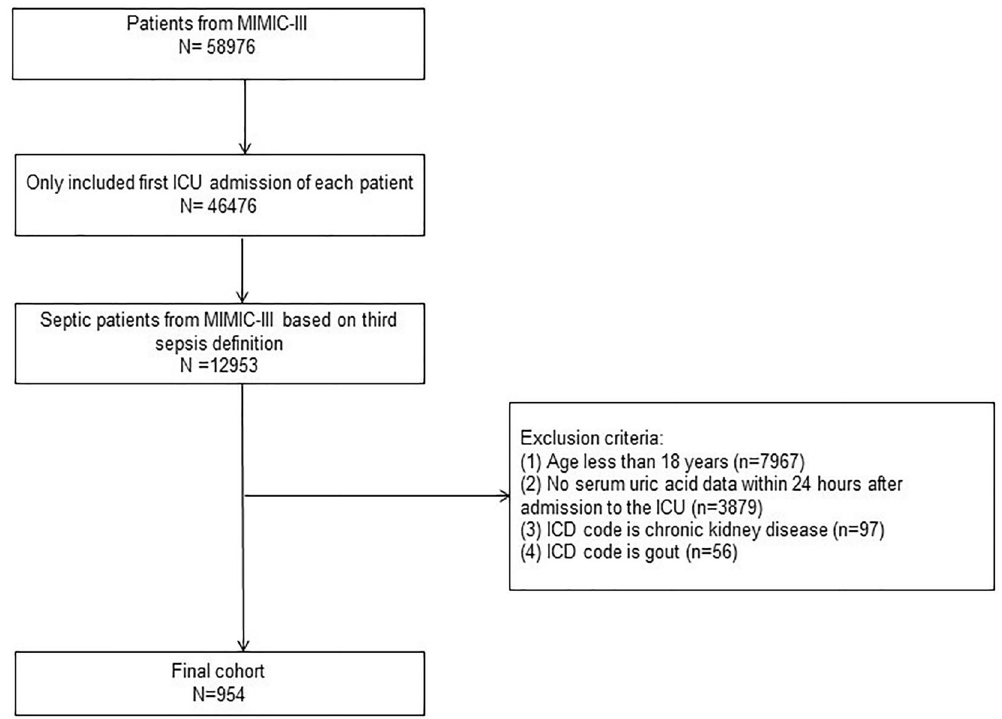
Figure 1. Flow diagram of the study. ICU Intensive Care Unit; ICD International Classification of